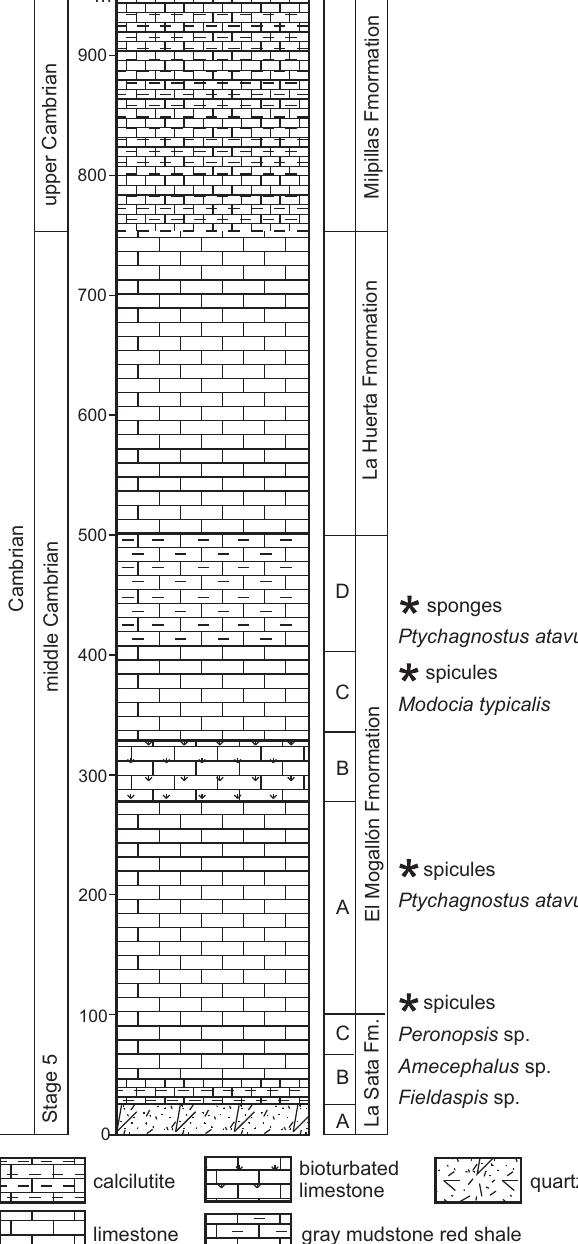
Fig. 3. Generalized stratigraphic column of the middle Cambrian El Mogallón Formation with members (A–D) with locations of sponges and spicules indicated (after Almazán-Vázquez